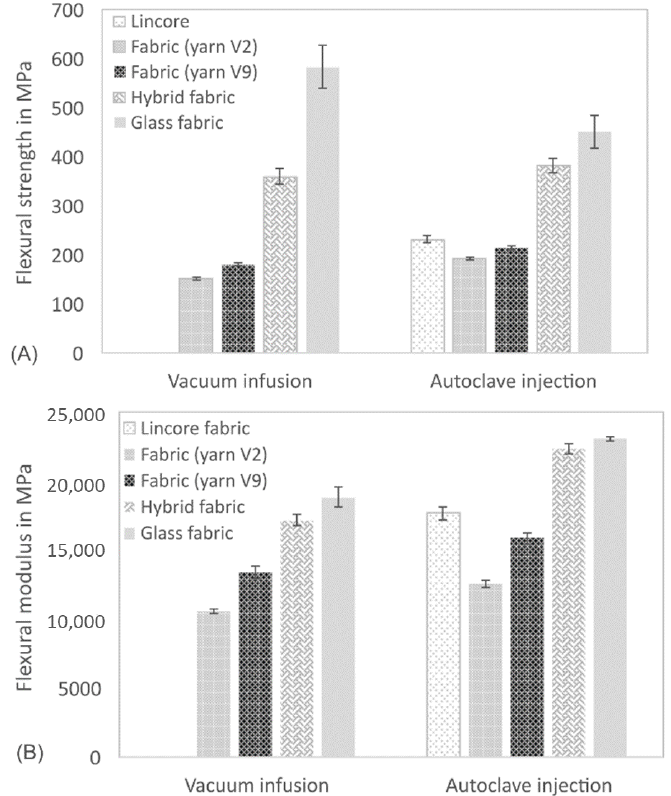
Figure 11. Flexural strength ( A ) and flexural modulus ( B ) of composites produced by vacuum infusion and autoclave injection. Results are shown as mean values with standard deviation as error bars.